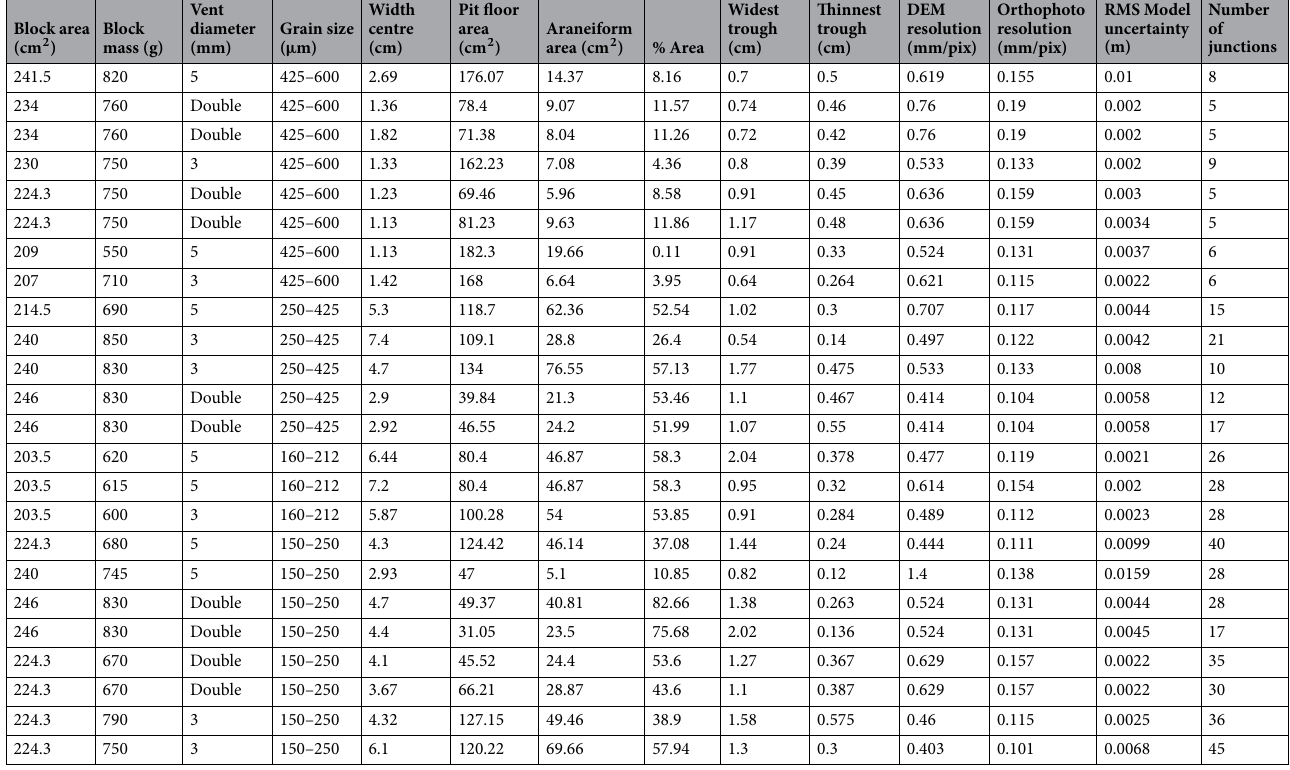
Table 1. Summary of measured and controlled